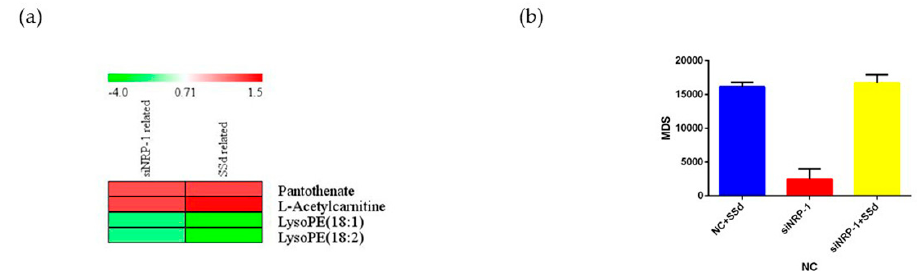
Figure 4. Fold changes of differential metabolites and MDS of all metabolites. ( a ) Heatmap of the fold changes of differential metabolites related to NRP-1 knockdown and SSd-treated; ( b ) MDS of all the metabolites detected with NC as control.